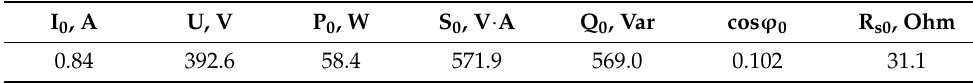
Table 1. Results of the no-load test.